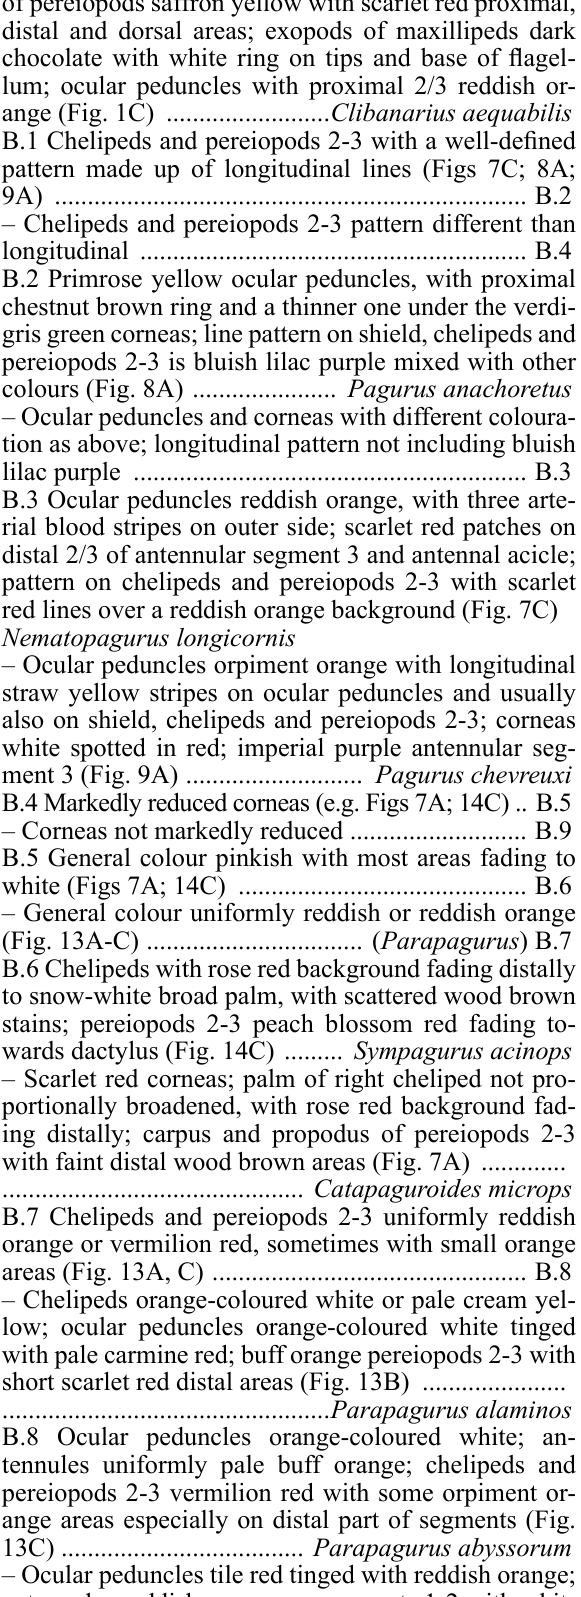
pereiopods 2-3 vermilion red with some orpiment or- ange areas especially on distal part of segments (Fig.